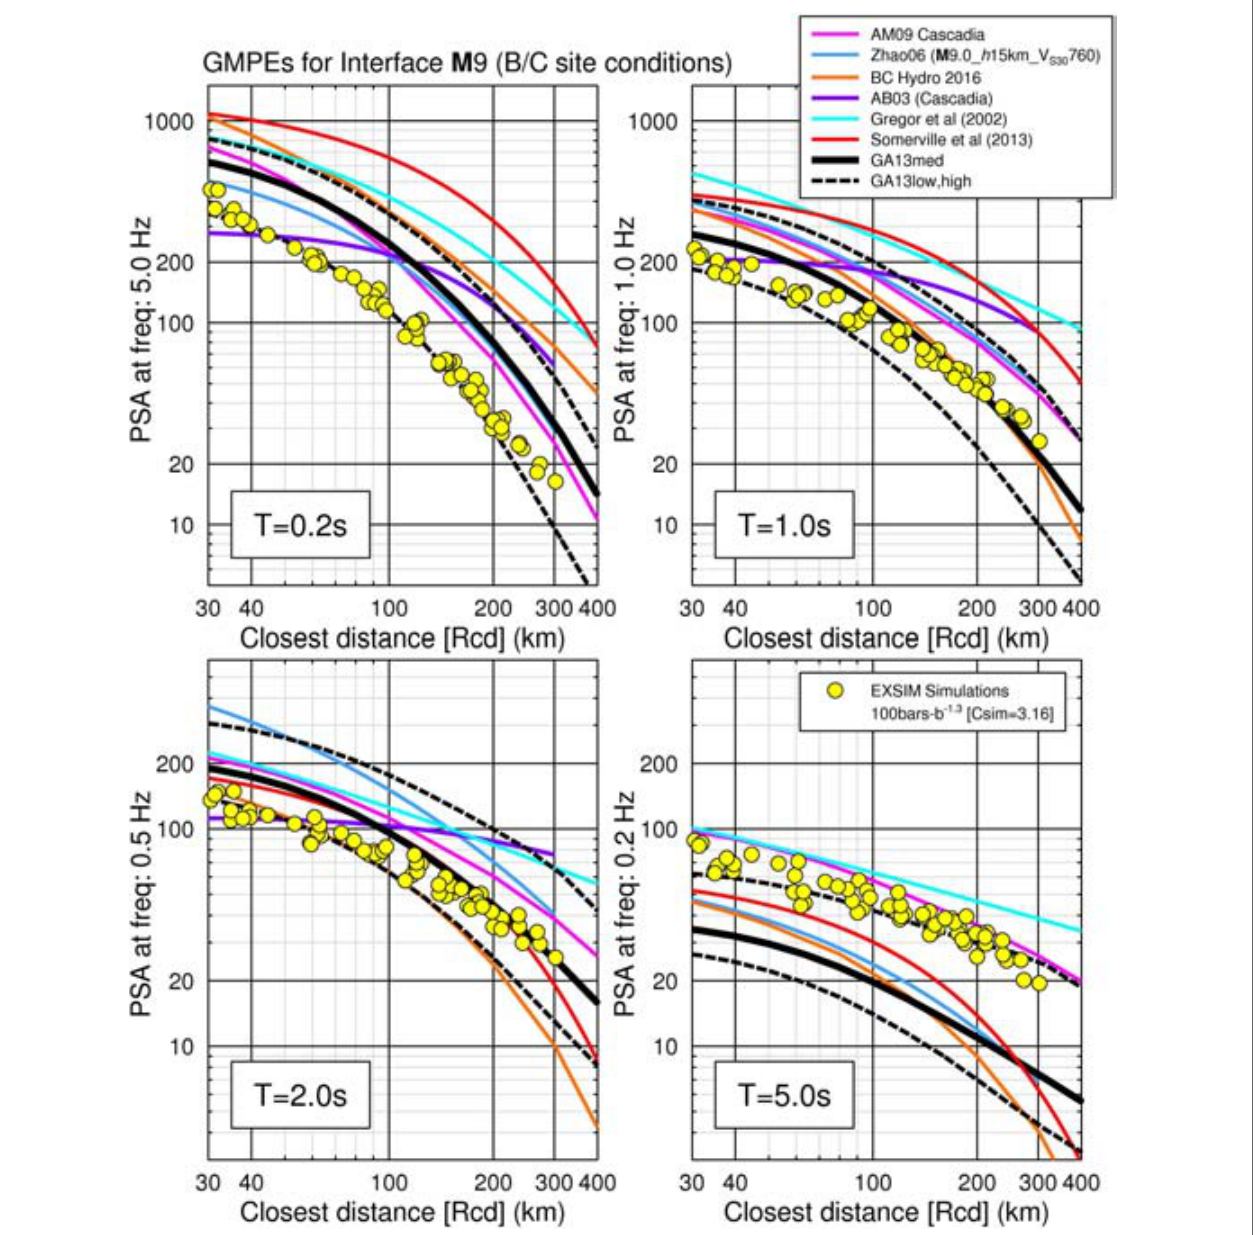
FIGURE 7 | EXSIM-simulated motions (yellow circles) and interface ground-motion prediction equations (GMPEs) for an M 9.0 interface event. The interface GMPEs are shown as magenta (AM09), blue (Zhao06), orange (BC Hydro 2016), purple (AB03), cyan (Gregor et al., 2002), red (Somerville et al., 2013), and black (GA13) curves. Japan to Cascadia site factor corrections have been applied to both Zhao et al. (2006) and Ghofrani and Atkinson (2013) models to account for the deeper soil profiles in Cascadia compared to Japan, for the same value of V s30 (see Ghofrani et al., 2012 for details). The models reflect forearc attenuation conditions.